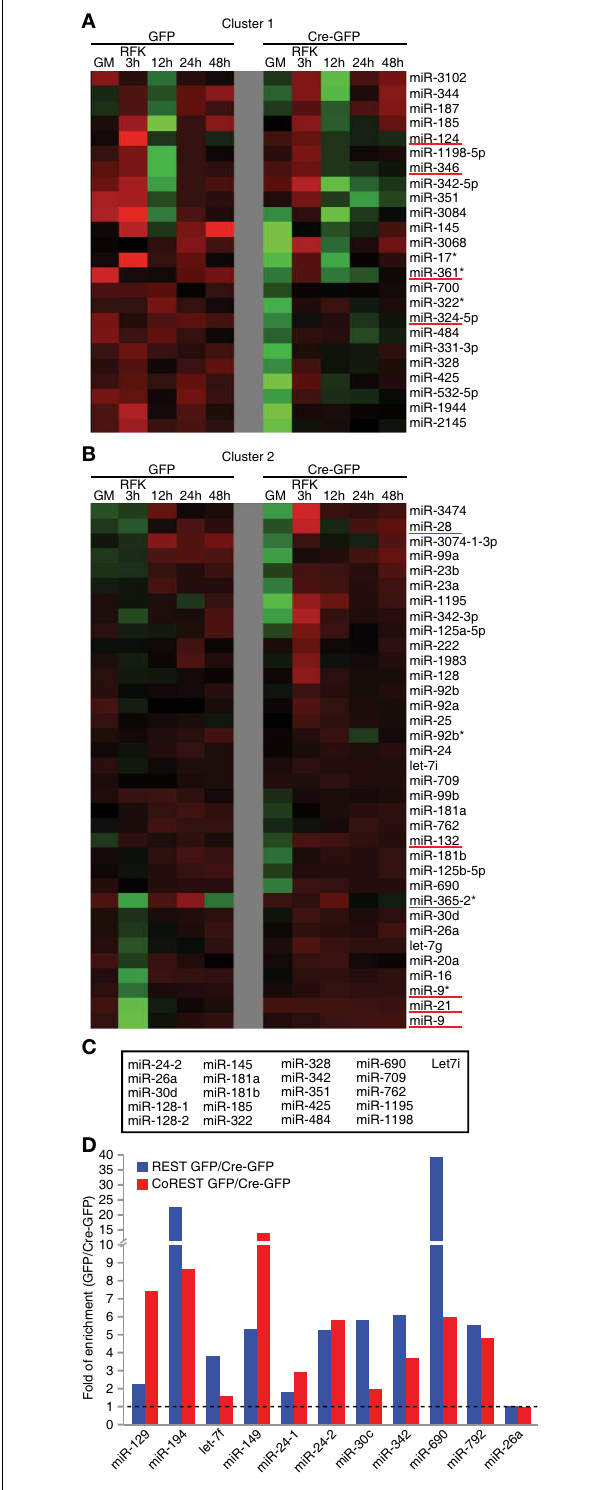
FIGURE 3 | Identification of novel REST miRNA targets. (A,B) In unsupervised clustering analyses, known REST miRNA targets formed clusters that also contained other miRNAs. Examples of clusters containing